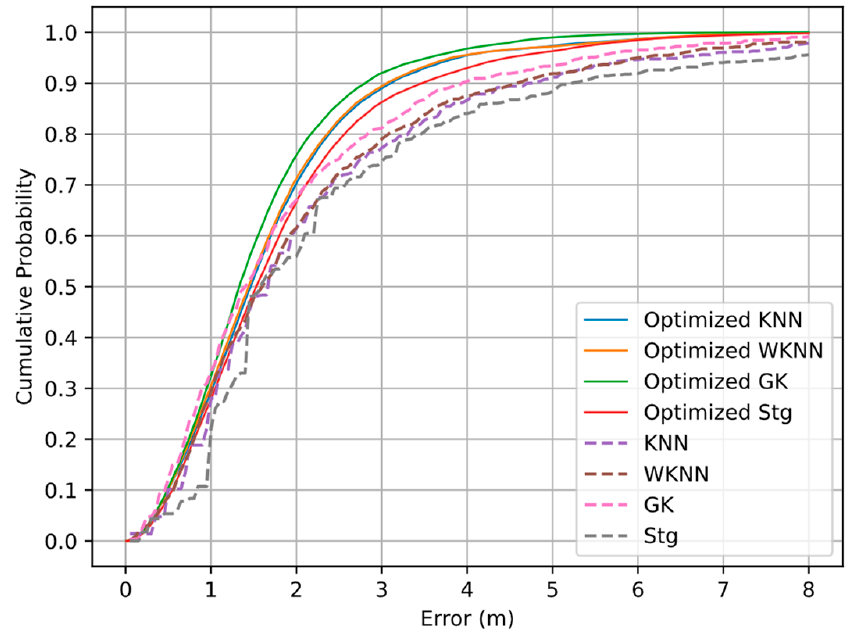
Figure 12. Positioning error CDF curves of Wi-Fi fingerprint-matching algorithms before and after optimization. Table 3. Cumulative error probability of different algorithms under fixed accuracy limit.